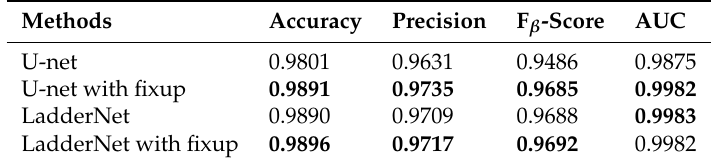
Table 2. Results on ELE data set.